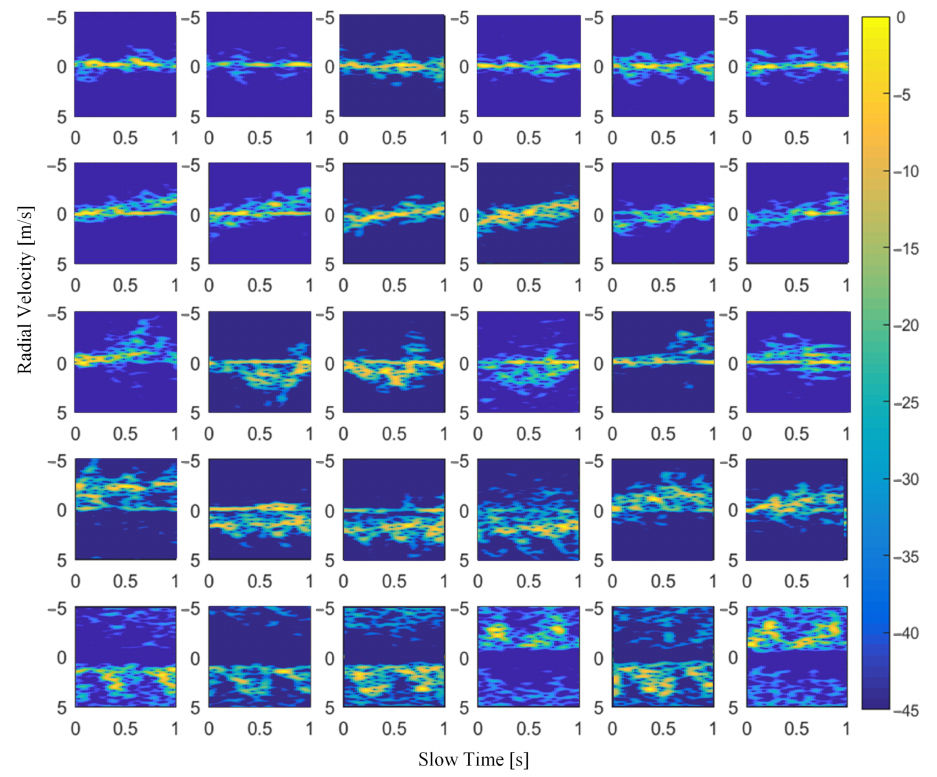
Figure 7. Typical MD signatures of five activities performed by six subjects. From top to bottom: box, circle, jump, run and walk. From left to right: Sub #1, Sub #2, Sub #3, Sub #4, Sub #5 and Sub #6. In each spectrogram, the radial velocity range is from − 5.14 m/s to 5.14 m/s, and the activity duration is 1 s. It is shown that every piece of MD signature is both activity-specific and